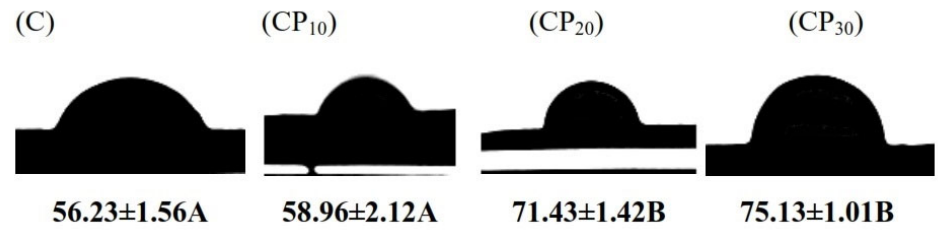
Figure 3. Water contact angle of various BSG samples; C, CP 10 , CP 20 , and CP 30 indicate unmodified samples and those treated by CP for 10, 20, and 30 min, respectively. Different uppercase letters indicate significant differences ( p < 0.05).